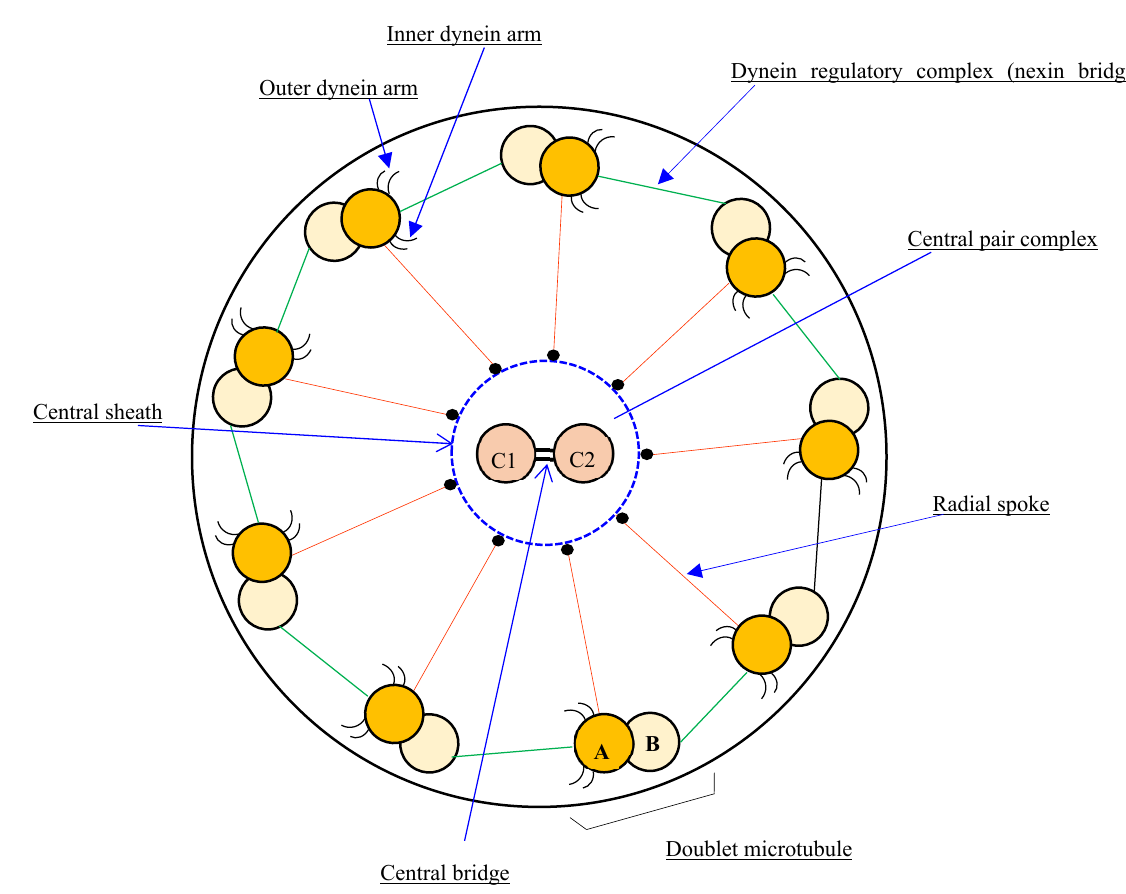
Figure 1. Diagram of the basic motile cilia structure showing the 9d + 2s microtubule arrangement pattern.